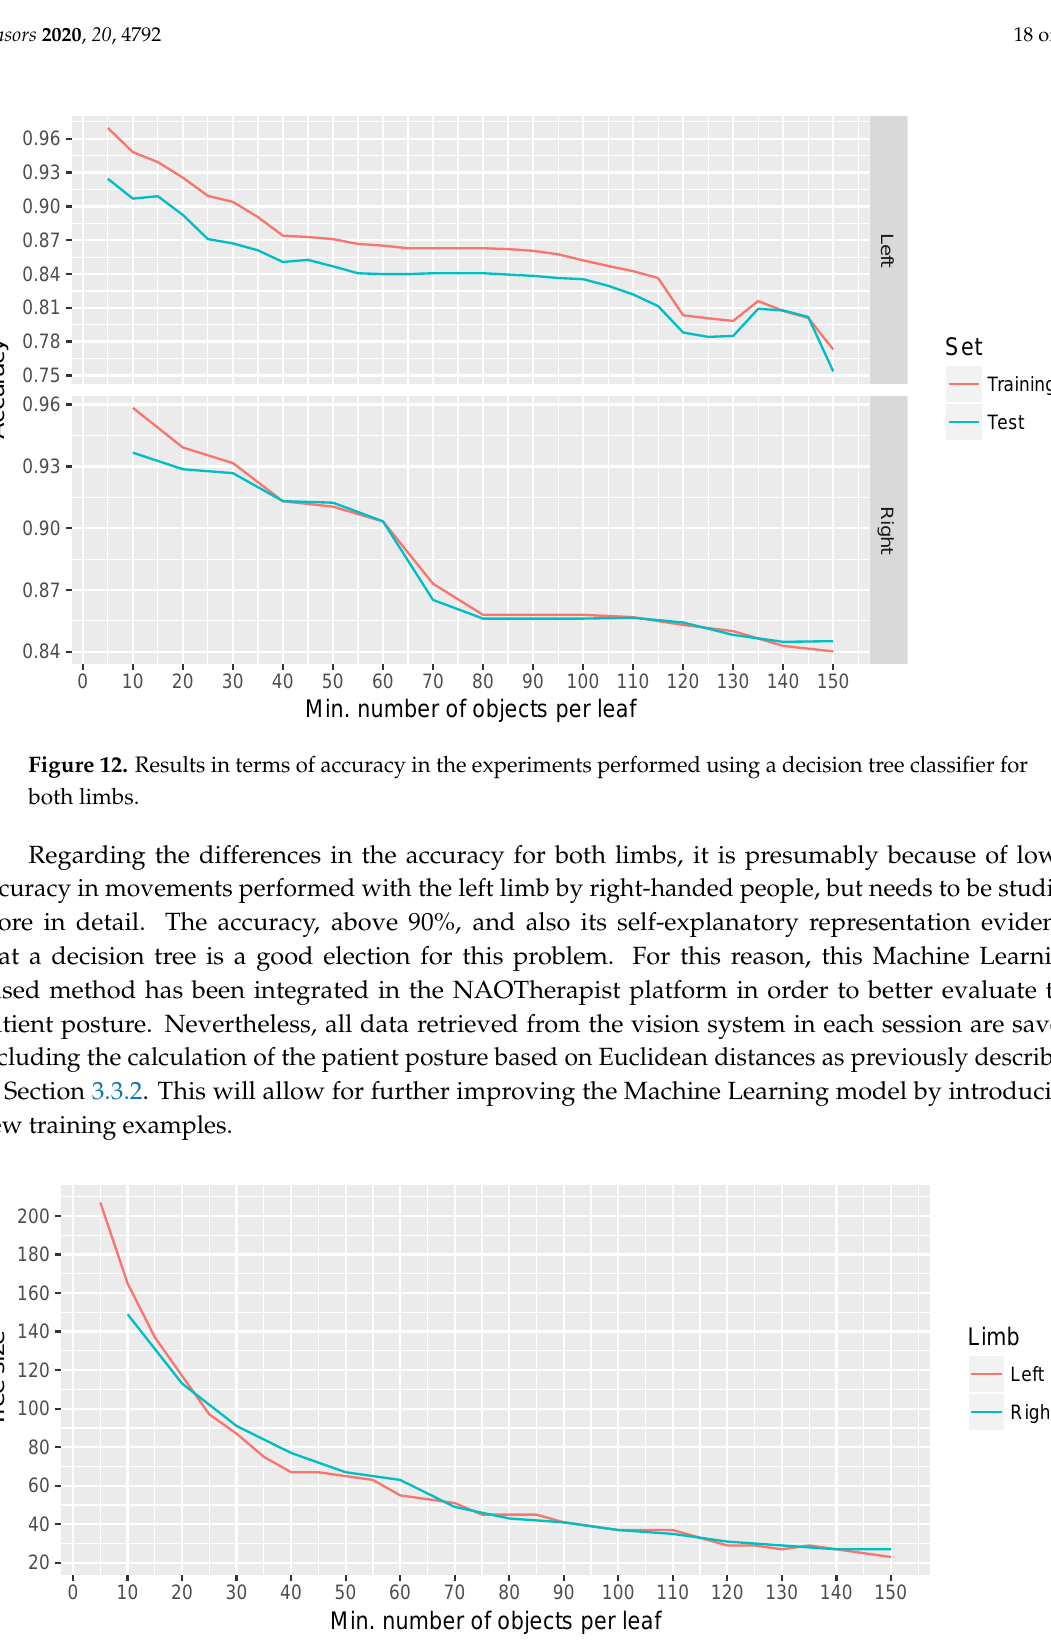
Figure 13. Results in terms of size of the tree in the experiments performed using a decision tree classifier for both